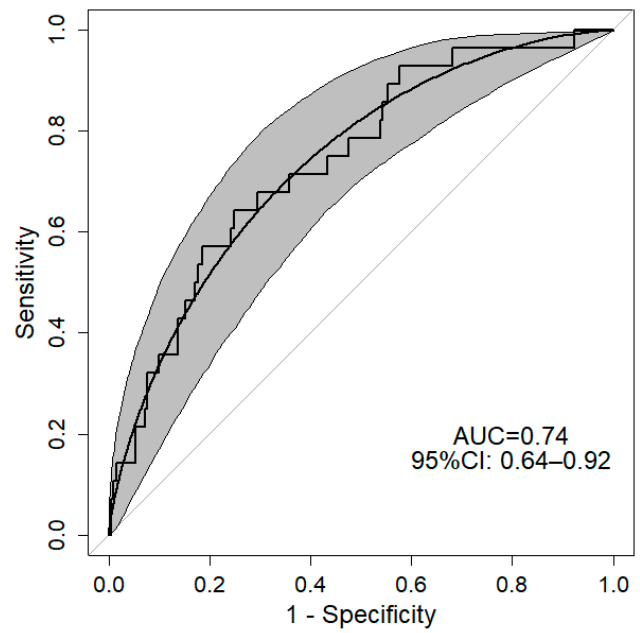
Figure 2. Observed and smoothed ROC curves with 95% confidence interval for the predictiveness of GDM. Grey area identifies 95% confidence interval of ROC. AUC: Area Under Curve; 95%CI: 95% Confidence Interval. ROC was estimated as a function of HtrA1 type of nutrition in the third trimester of gestation and BMI before pregnancy.